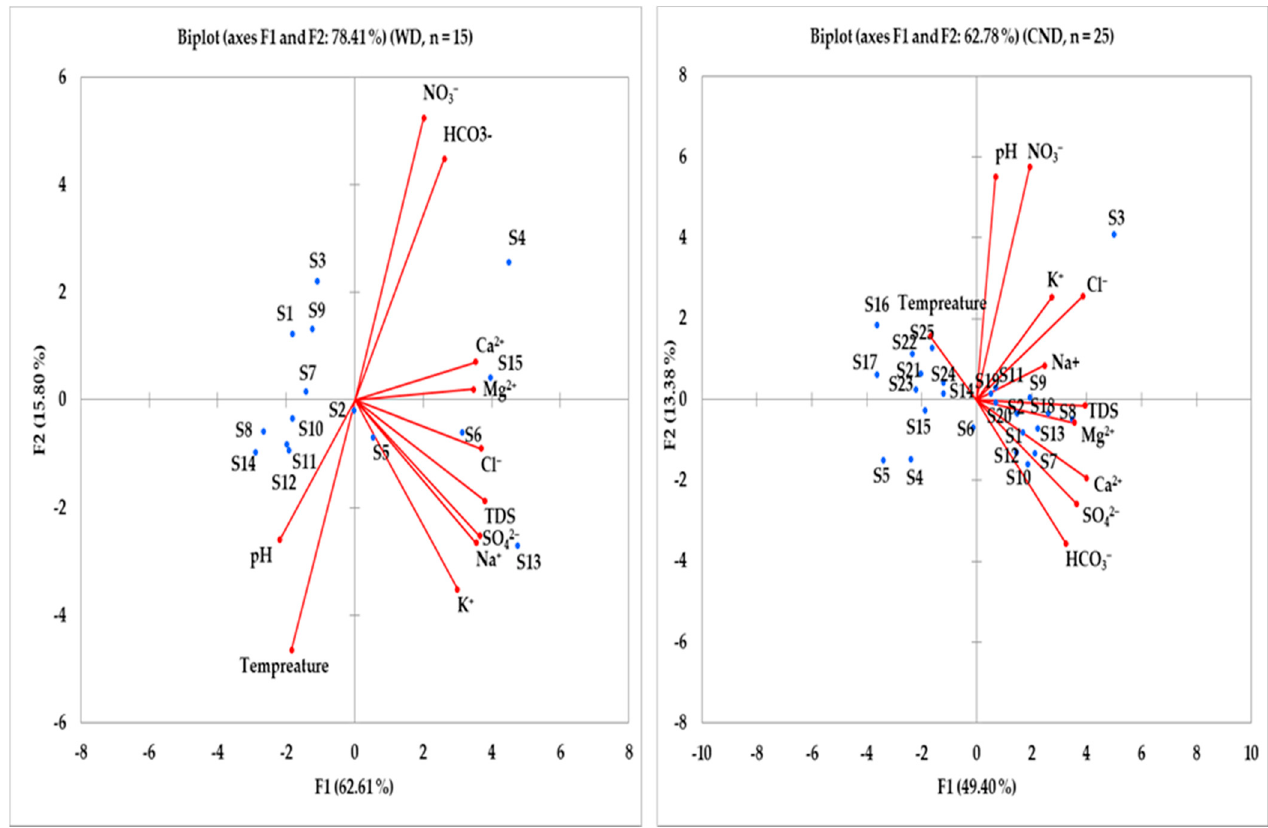
Figure 5. Biplot of the principle component analysis for the first two components of different physicochemical parameters for groundwater samples collected from the Western Desert (WD) and Central Nile Delta (CND). S indicates samples.